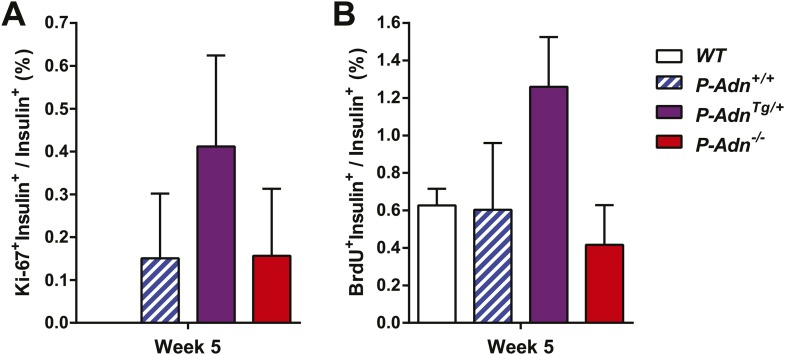
Quantitation of proliferating β-cells.All islets on the pancreas sections were counted and calculated for the percentage of Ki-67+ insulin+ cells (A) or BrdU+ insulin+ cells (B) within the population of insulin+ cells. n ≥ 3 mice per genotype. Data are presented as the mean ± SEM. Related to Figure 7F,G.